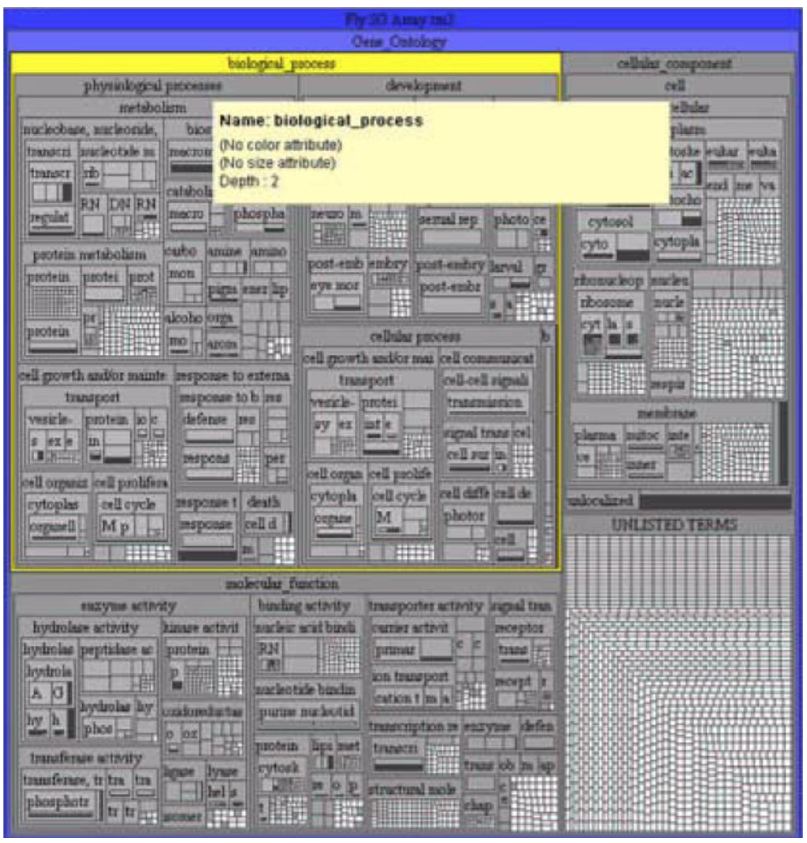
Figure 4. Gene ontology in the form of a treemap [35].